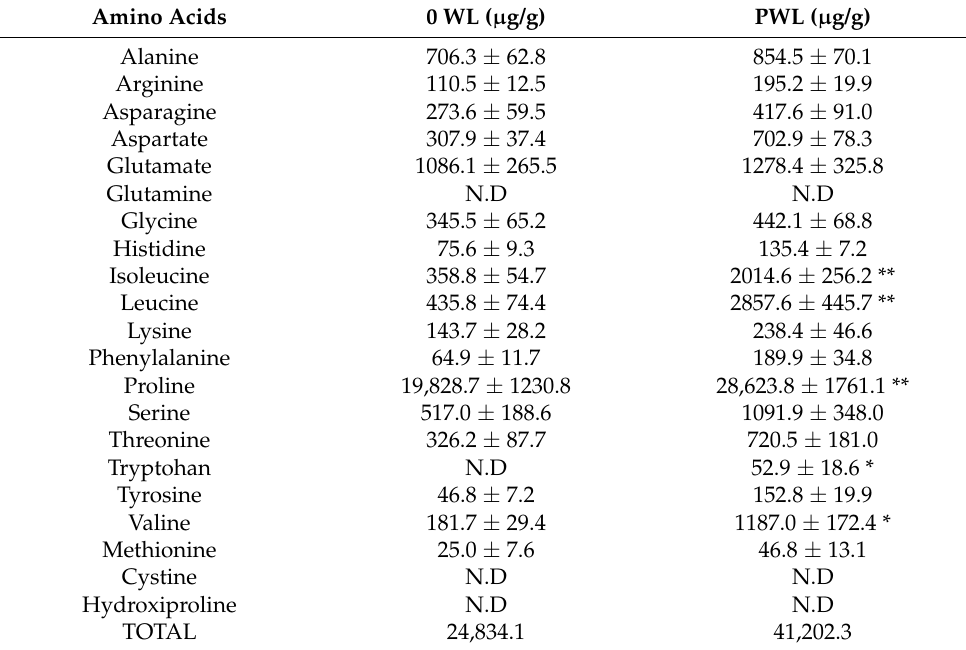
Table 1. Total amino acid content of 0 WL and PWL by UHPLC-Q-TOF/MS.